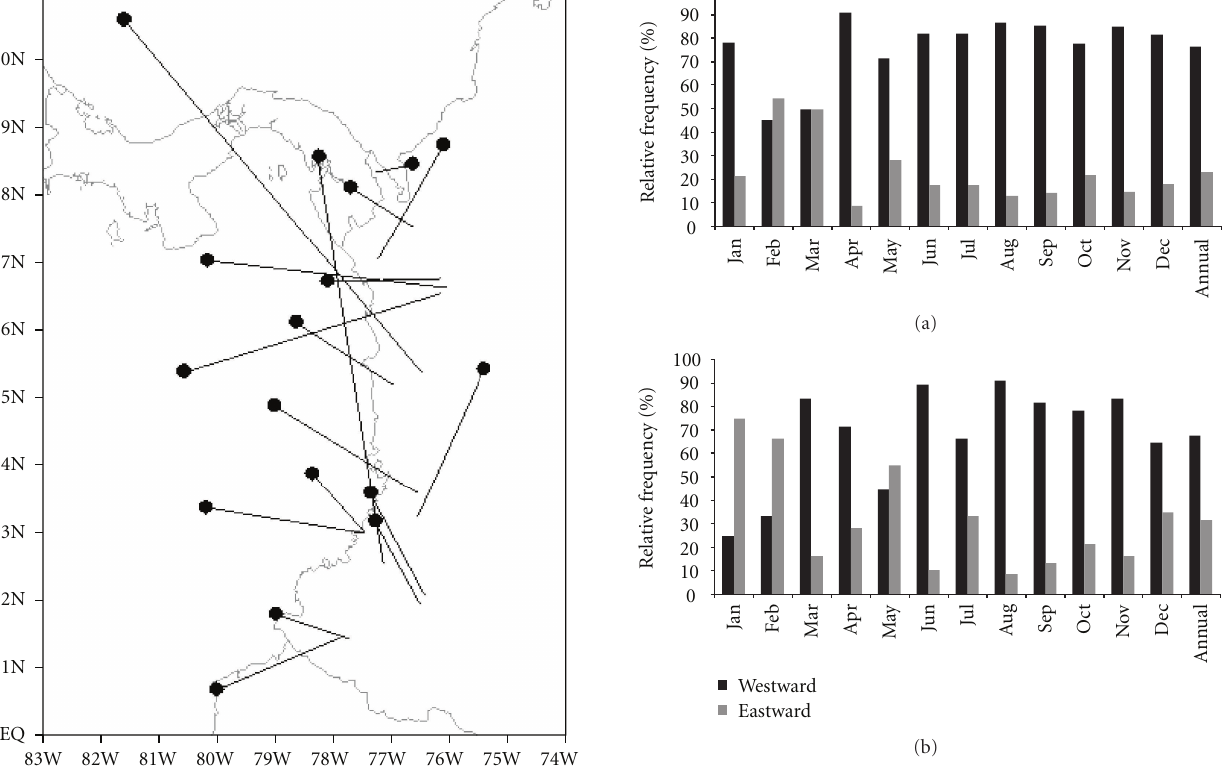
Figure 6: Continental convective systems displacements observed in July 2003. Black dot represents the position of the MCS at dissipation stage.